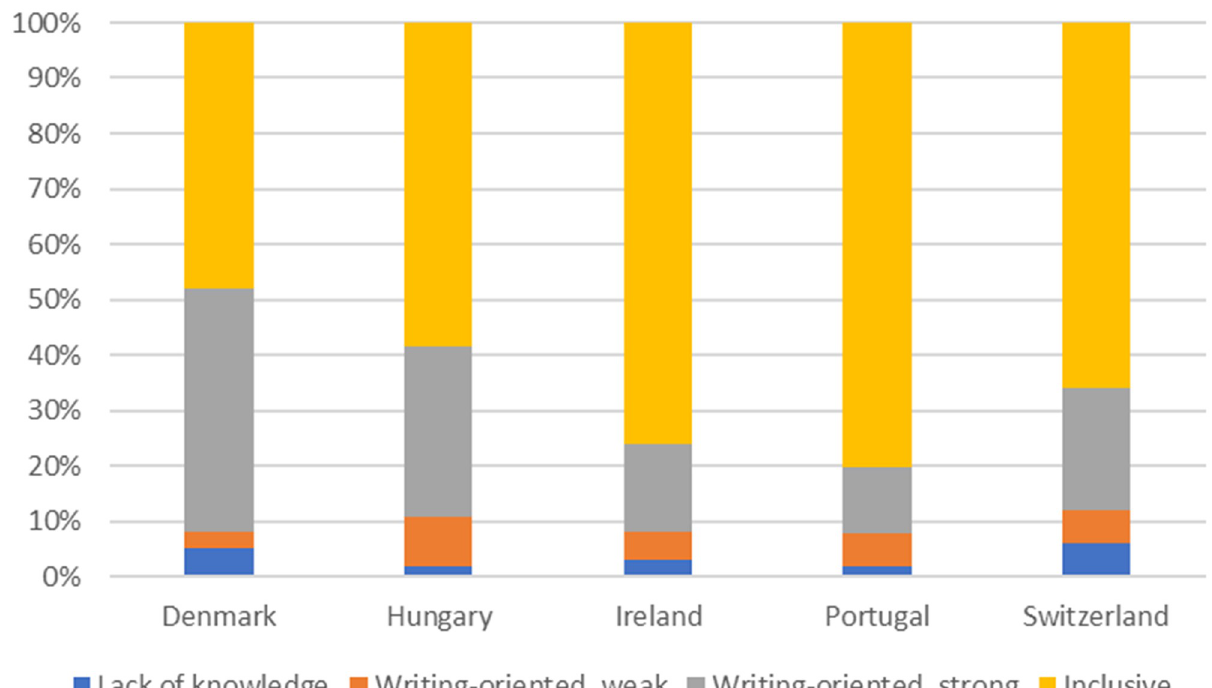
Fig 3. Distribution of authorship views across countries (shares calculated using the atmeans margins command to reflect the same average student across countries).